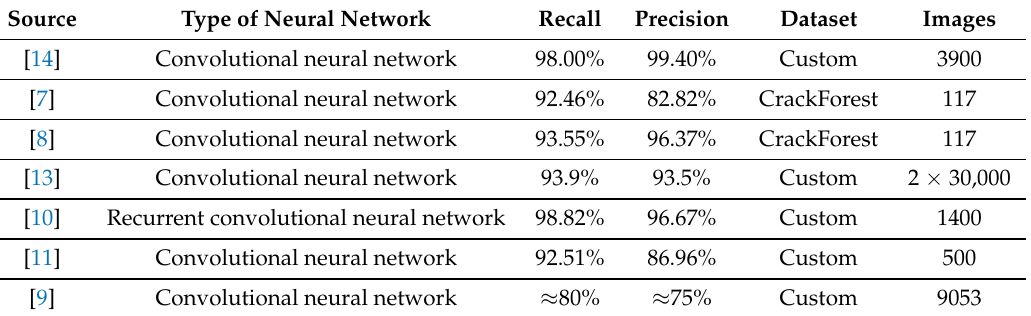
Table 3. Research on 2D image-based pavement distress detection using neural networks.